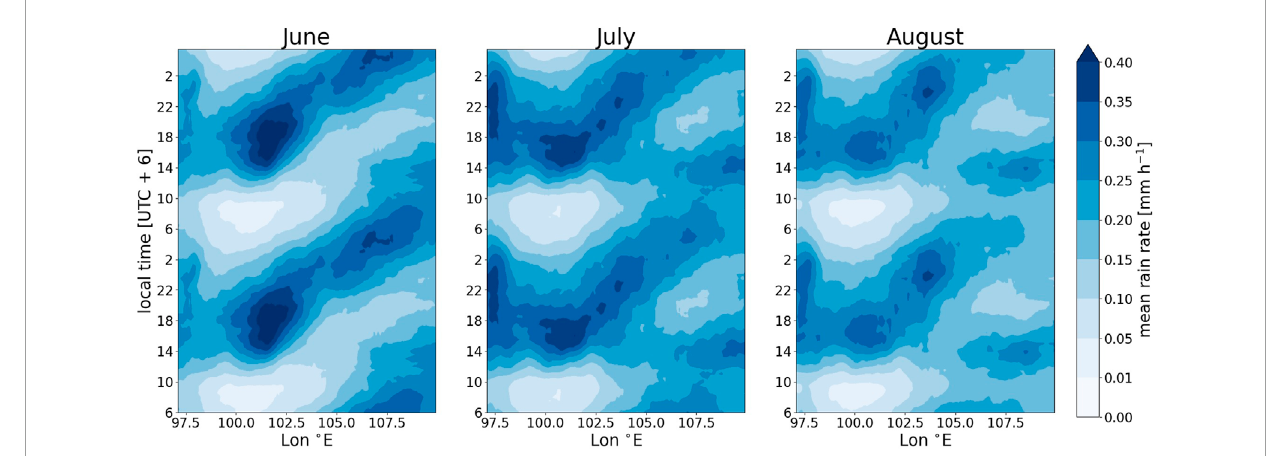
FIGURE 5 Hovmöller (time-longitude) diagrams showing the diurnal propagation of summer precipitation from the eastern edge of the TP ( ∼ 100 ° E) to its downstream regions on the leeward side for June, July, and August. The climatological mean rain rates were computed from half-hourly GPM IMERG v06 data for the time period 2000–2019 and averaged over latitudes 28 ° N-34 ° N. The diurnal cycle is repeated twice for